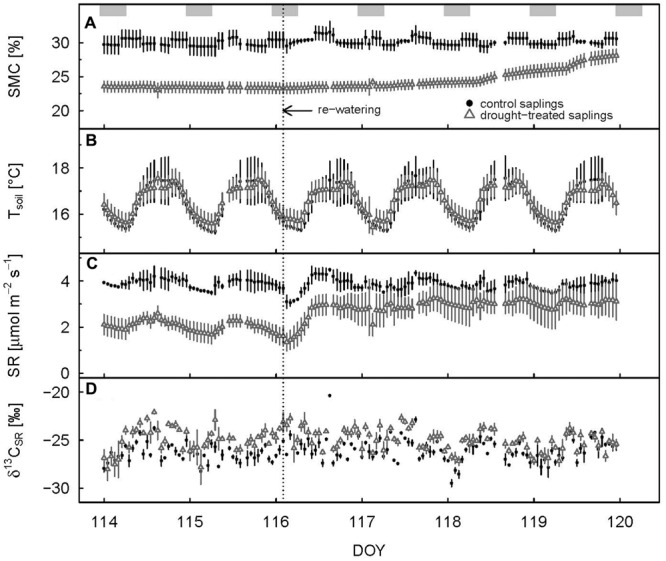
Hourly mean values of soil moisture (A), soil temperature (B), soil respiration (C), and δ13C value of soil respiration (D) for control and drought-treated saplings 2 days before and 4 days after re-watering. Shaded rectangles at the top indicate nighttime. Re-watering is represented by the dashed vertical line. Error bars show the standard errors; data are only shown when at least two replicates were available.